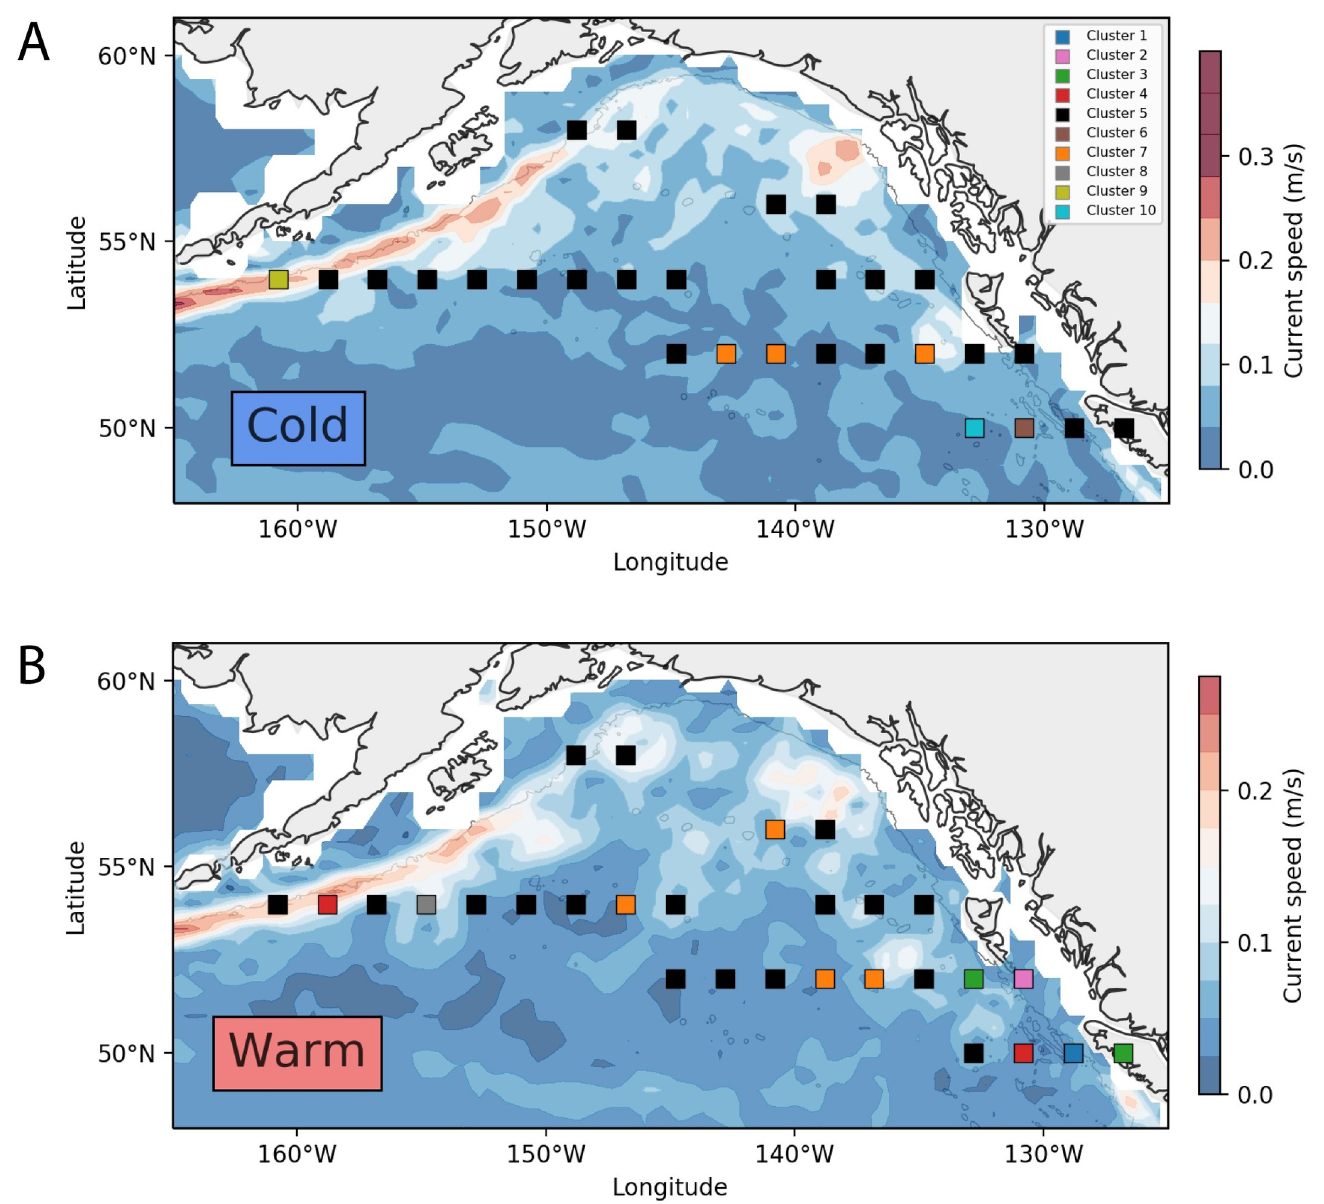
Fig 9. Spatial organization of clusters during years of temperature anomalies. (A) Community clusters occurring during pooled anomalously cold SST years, and their distribution relative to mean current speeds during these cold years; (B) Community clusters occurring during pooled anomalously warm SST years, and their distribution relative to mean current speeds during these warm